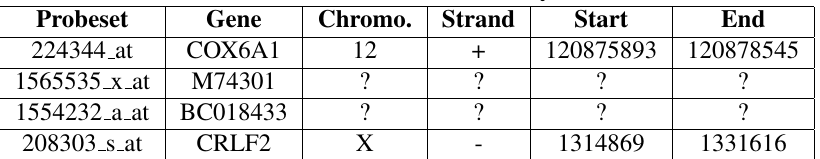
Table 3: Some Probesets Annotation by